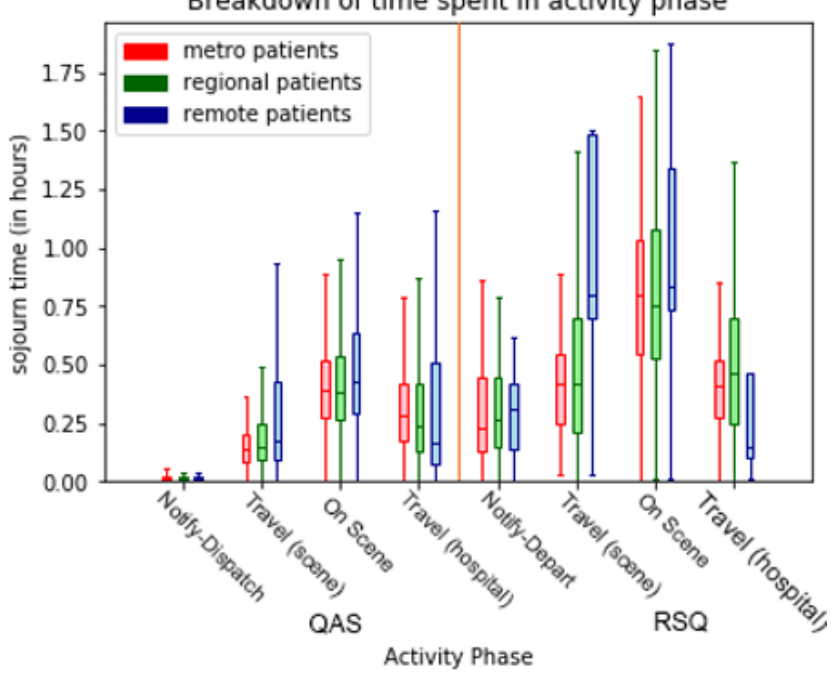
Figure 13. Comparison (by destination hospital remoteness) of transport segment durations—ground and air.